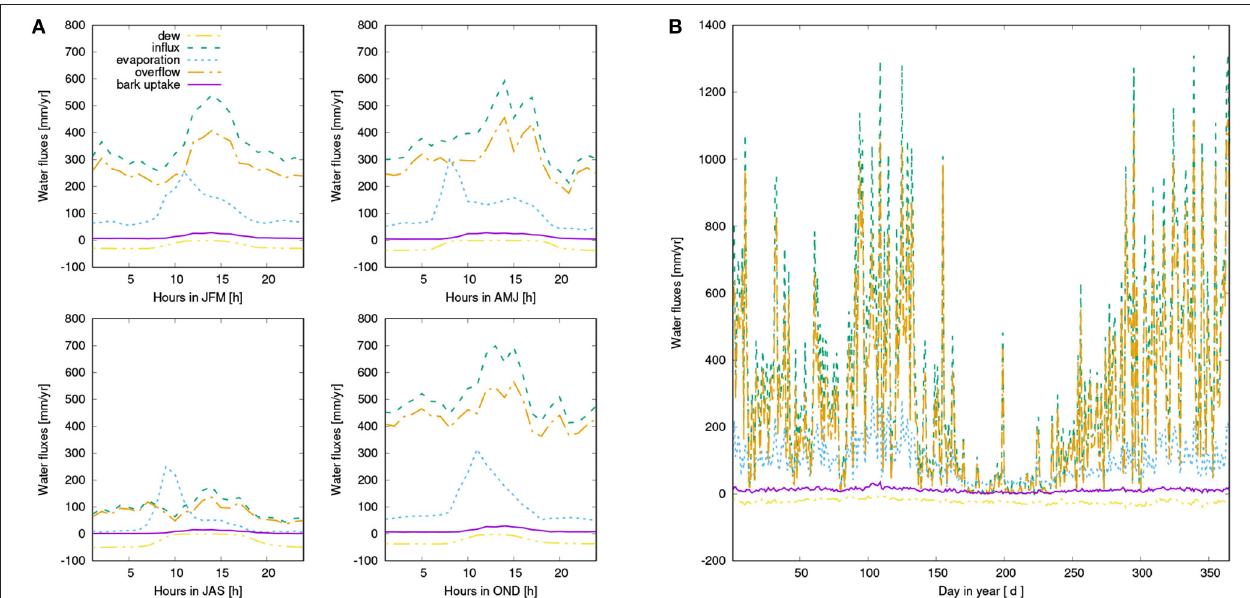
FIGURE 6 | (A) Mean diurnal water balance of the simulated canopy for four seasons: Dew input (purple), rainfall (green), overflow from the canopy due to saturation of the interception reservoir or the NV epiphytes (orange), which is directed either to throughfall or to the bark reservoir, evaporation from the interception reservoir or the NV epiphytes (blue), and bark water uptake (yellow). (B) Seasonal pattern of water fluxes, same color coding as in (A)